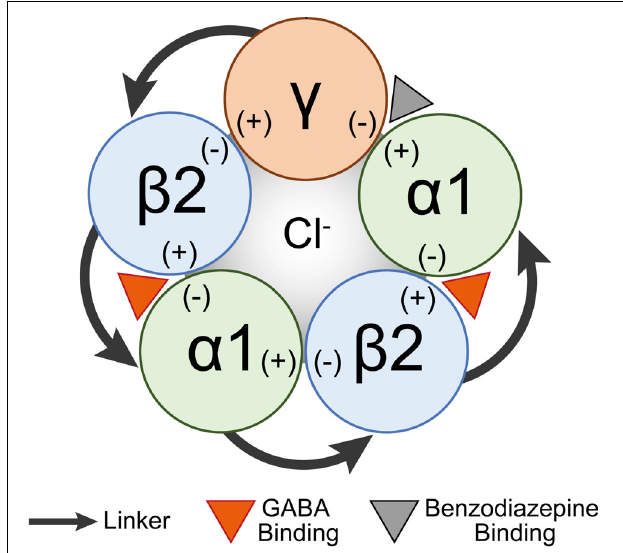
FIGURE 1 | A schematic diagram of a concatenated pentamer GABA A receptor construct. Linkers concatenating subunits are shown as arrows. The GABA binding site (orange arrowhead) is shown between the β 2(+) and α (–) interfaces and the benzodiazepine binding site (gray arrowhead) is between the α 1(+) and γ (–)